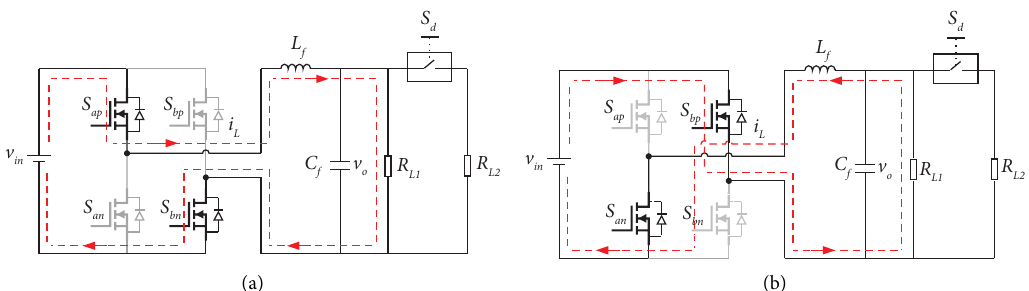
Figure 2: Te equivalent circuit of the full-bridge single-phase VSI. (a) S S ap � S bn � OFF.